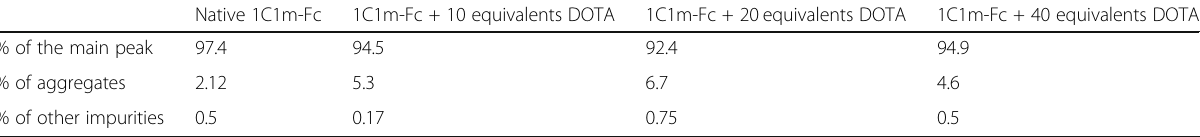
Table 1 HPLC analysis results of the native and conjugated 1C1m-Fc Native